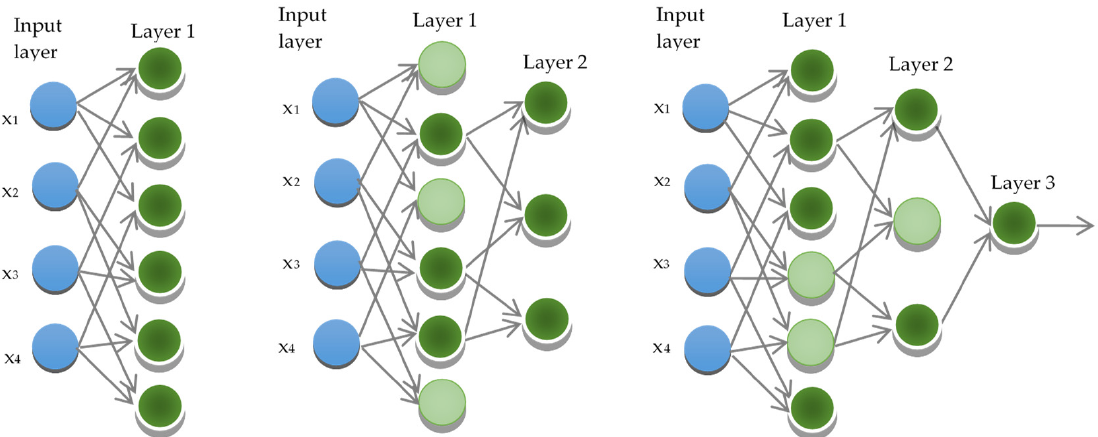
Figure 7. An example of layer development during the training of a GMDH—ANN with four inputs.